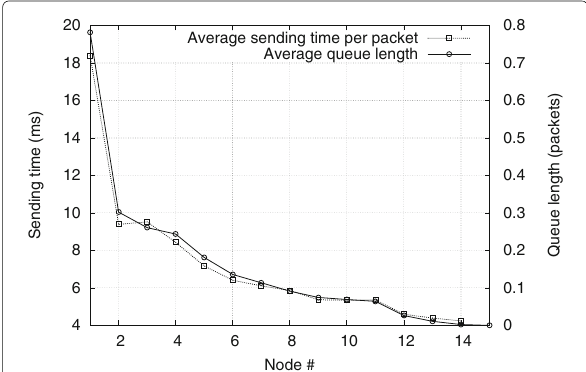
Fig. 3 Average sending time per packet in MAC and the average queue length